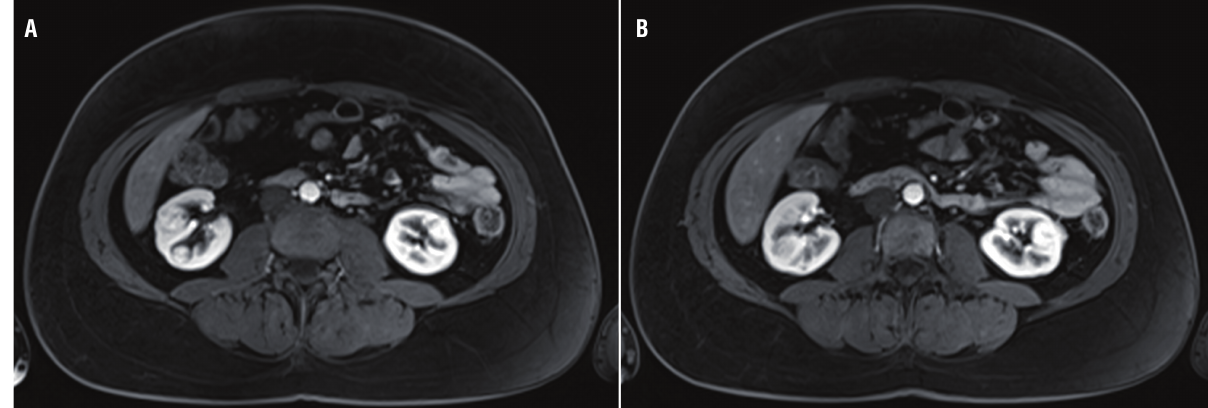
Figure 1 - Abdominal Magnetic